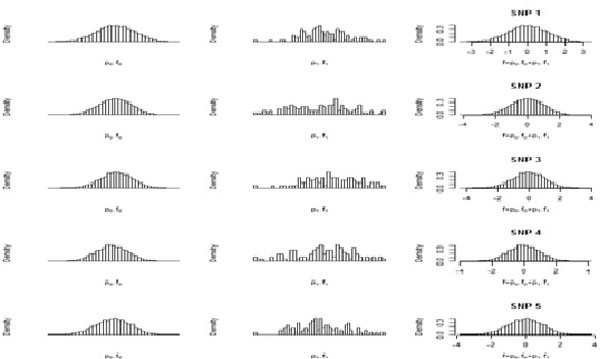
A part of the simulated data for p1=0.05.